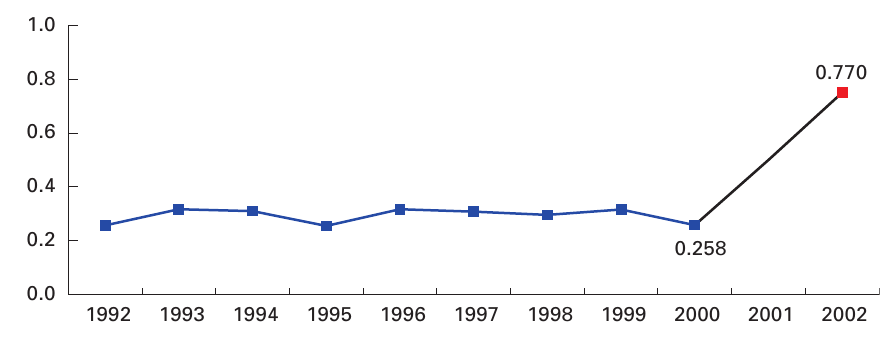
Impact factor Schweizerische Medizinische Wochenschrift (1992–2000) and Swiss Medical Weekly, 2002. ISI covered the old title Schweiz Med Wschr until the end of 2000, and then began coverage of the Swiss Medical Weekly in 2001. The title Swiss Medical Weekly appeared in the 2001 Journal Citation Reports (JCR), the ISI product which lists impact factors, with only an imme- diacy index because articles were not pub- lished under this title during this impact factor period (1999 and